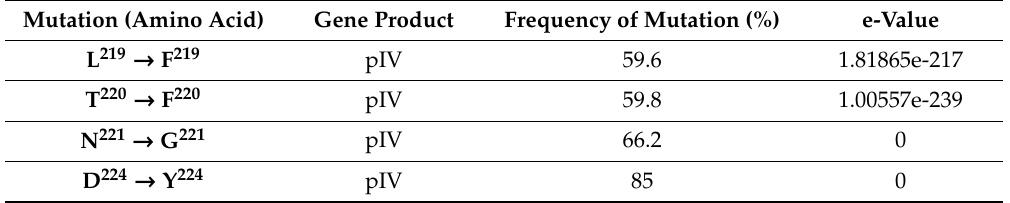
Figure 2. Genome maps of PEar1, PEar2, PEar4 and PEar6 and comparison between the genomes and reference phage IKe using a BLASTn analysis. The PEar phages display a modular genome organization, like that of previously described filamentous phages IKe, Fd or M13. The following four usual modules of filamentous phages are distinguishable: the replication module (blue), the structural module (green), the assembly module (orange) and the regulator module (yellow). The gene names and their encoding proteins with functional annotation (respectively at the bottom and top) follow the same numbering as their counterparts in IKe (adapted from EasyFig [37]). An alignment of the amino acid sequence (each colored bar represents a different amino acid) of pIV with PEar1 as reference shows that there are some mutations in the other sequences, indicated as colored bars. pIV from PEar4 and pIVa from PEar6 have accumulated mutations at the C-terminal end of the protein sequence. Table 2. Overview of the non-synonymous SNPs of PEar2 compared to PEar1 as determined with iVar [36]. The frequency of the specific mutation is given as well as the e-value. Mutations are located in the gene encoding pIV and cluster together in one region inside the amino acid